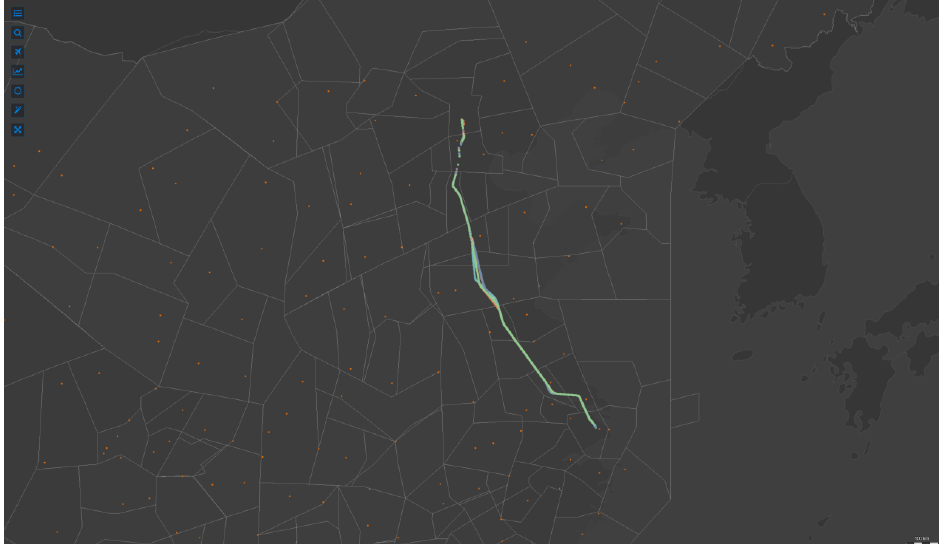
Figure 9. The flight trajectories of the urban air route from Beijing (ZBAA) to Shanghai Hongqiao (ZSSS).